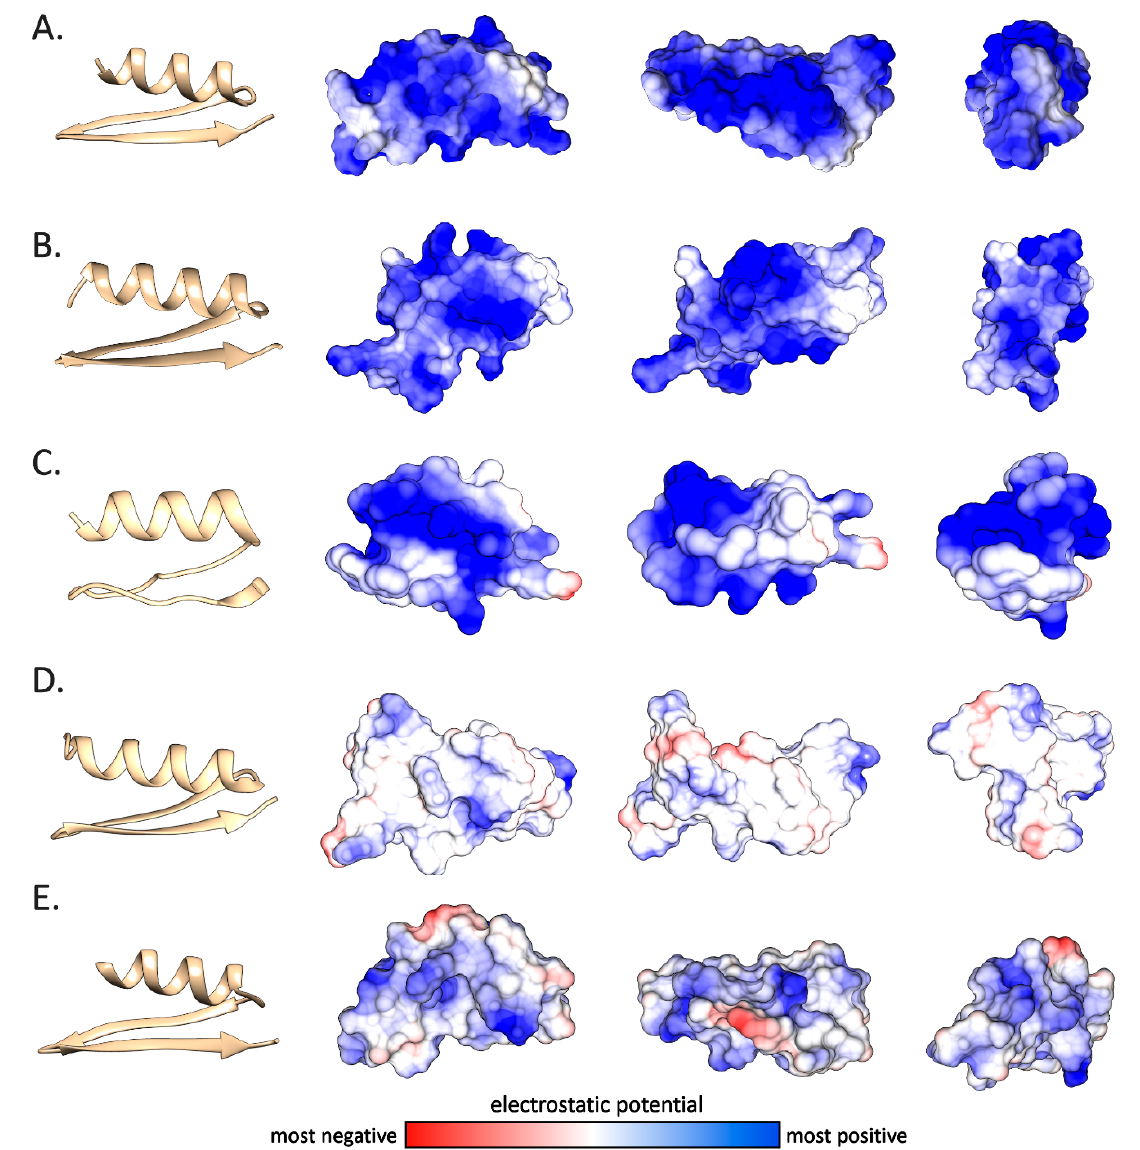
Figure 7. Ribbon structural models and electrostatic potential of five mytilins, displayed on the molecular surface of the molecules, rotated on the three main axes. Panel A : T. hirsuta mytilin 2. Panel B : M. galloprovincialis mytilin L. Panel C : M. galloprovincialis pseudomytilin 2. Panel D : P. canaliculus mytilin 1. Panel E : P. viridis mytilin 5.